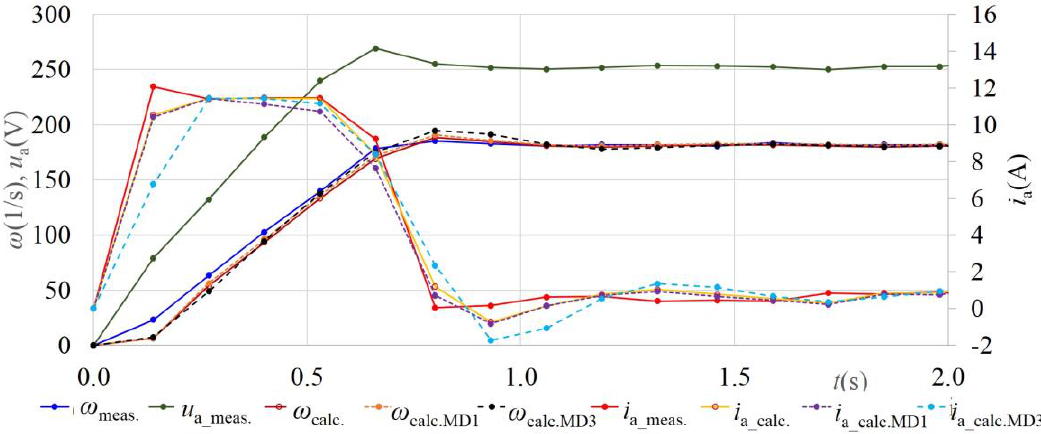
Figure 14. The simulated motor speed and current using R MD1 , R MD2 , and R MD3 for MD2 values.